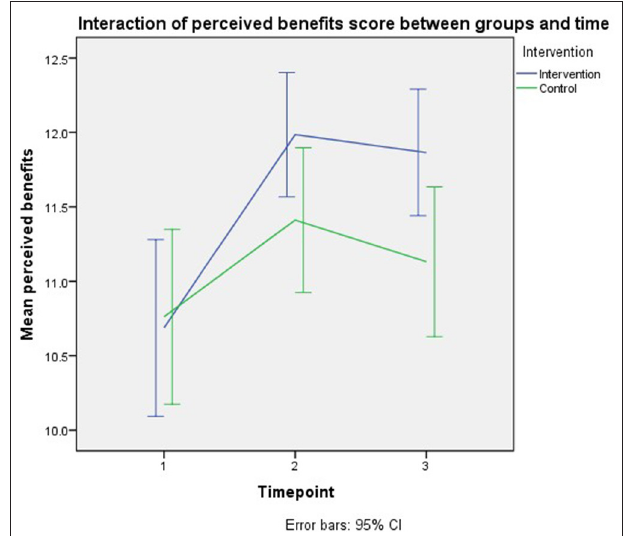
FIGURE 3 | Interaction of perceived susceptibility scores between groups and time.